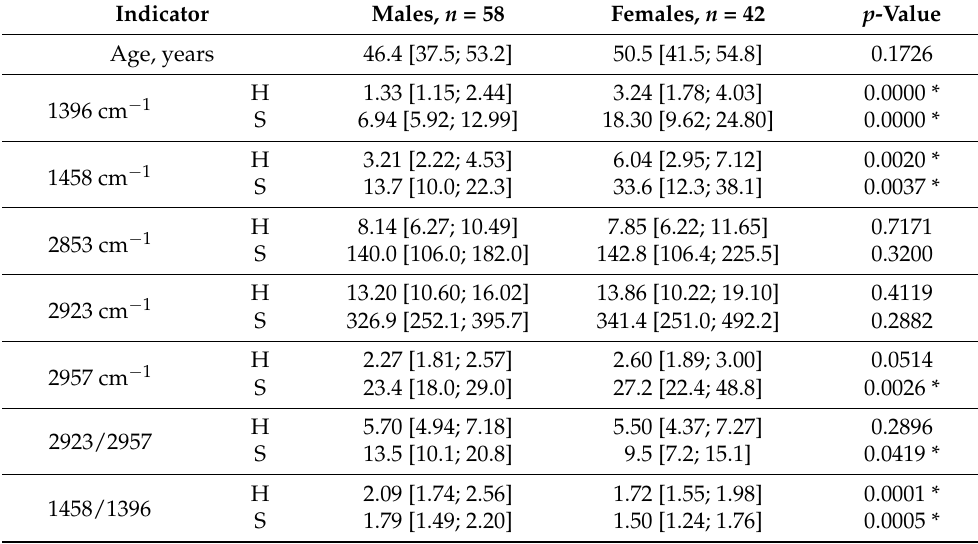
Table 3. Characteristics of the salivary IR spectra depending on